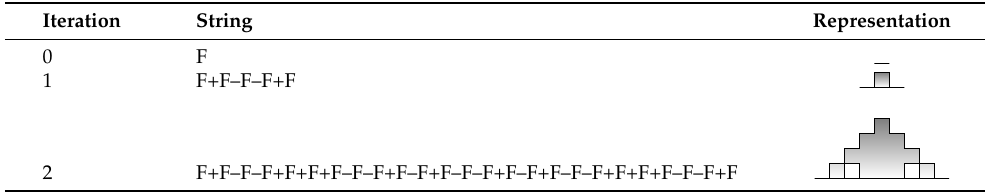
Table 4. Result of three iterations of the presented Koch curve using L-systems. Iteration String